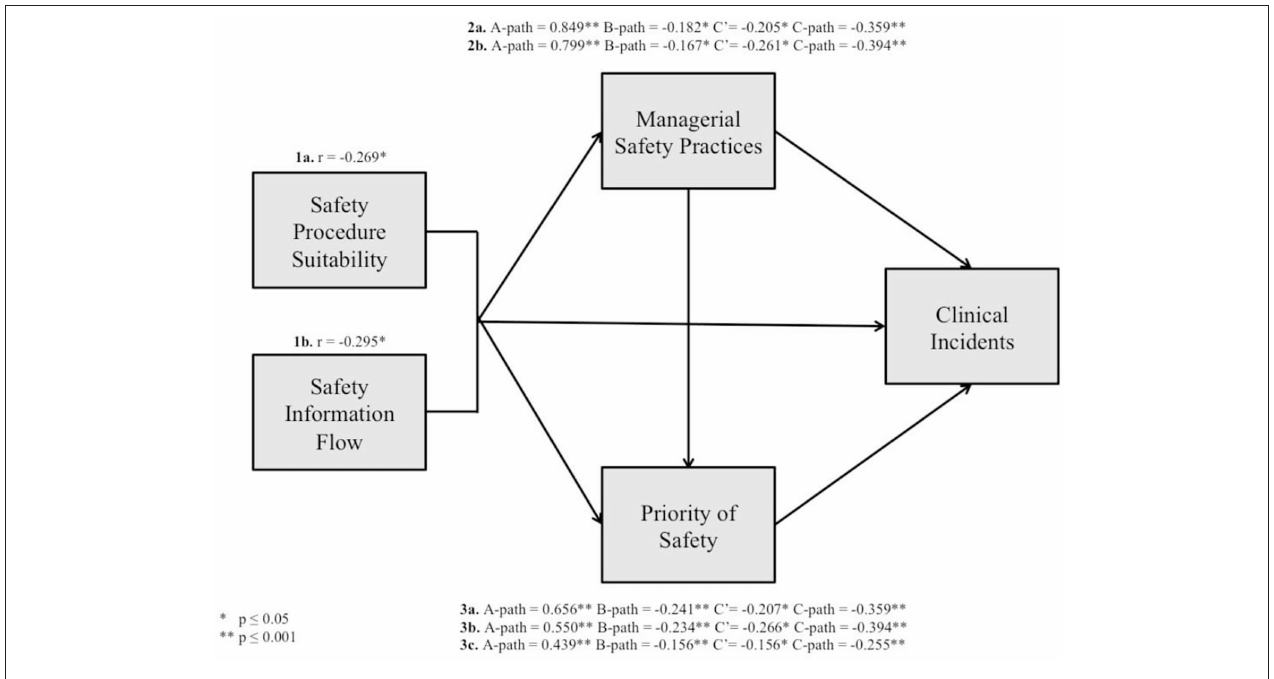
FIGURE 3 | The tested theoretical